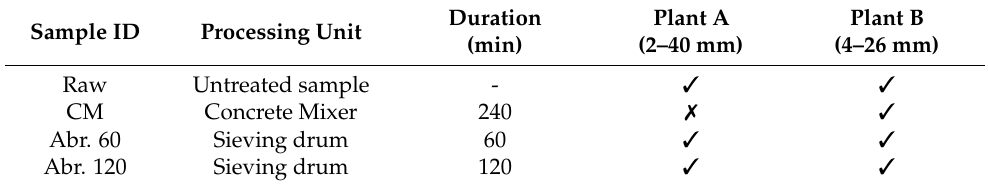
Table 2. Parameters of the abrasion tests performed on the samples collected at plants A and